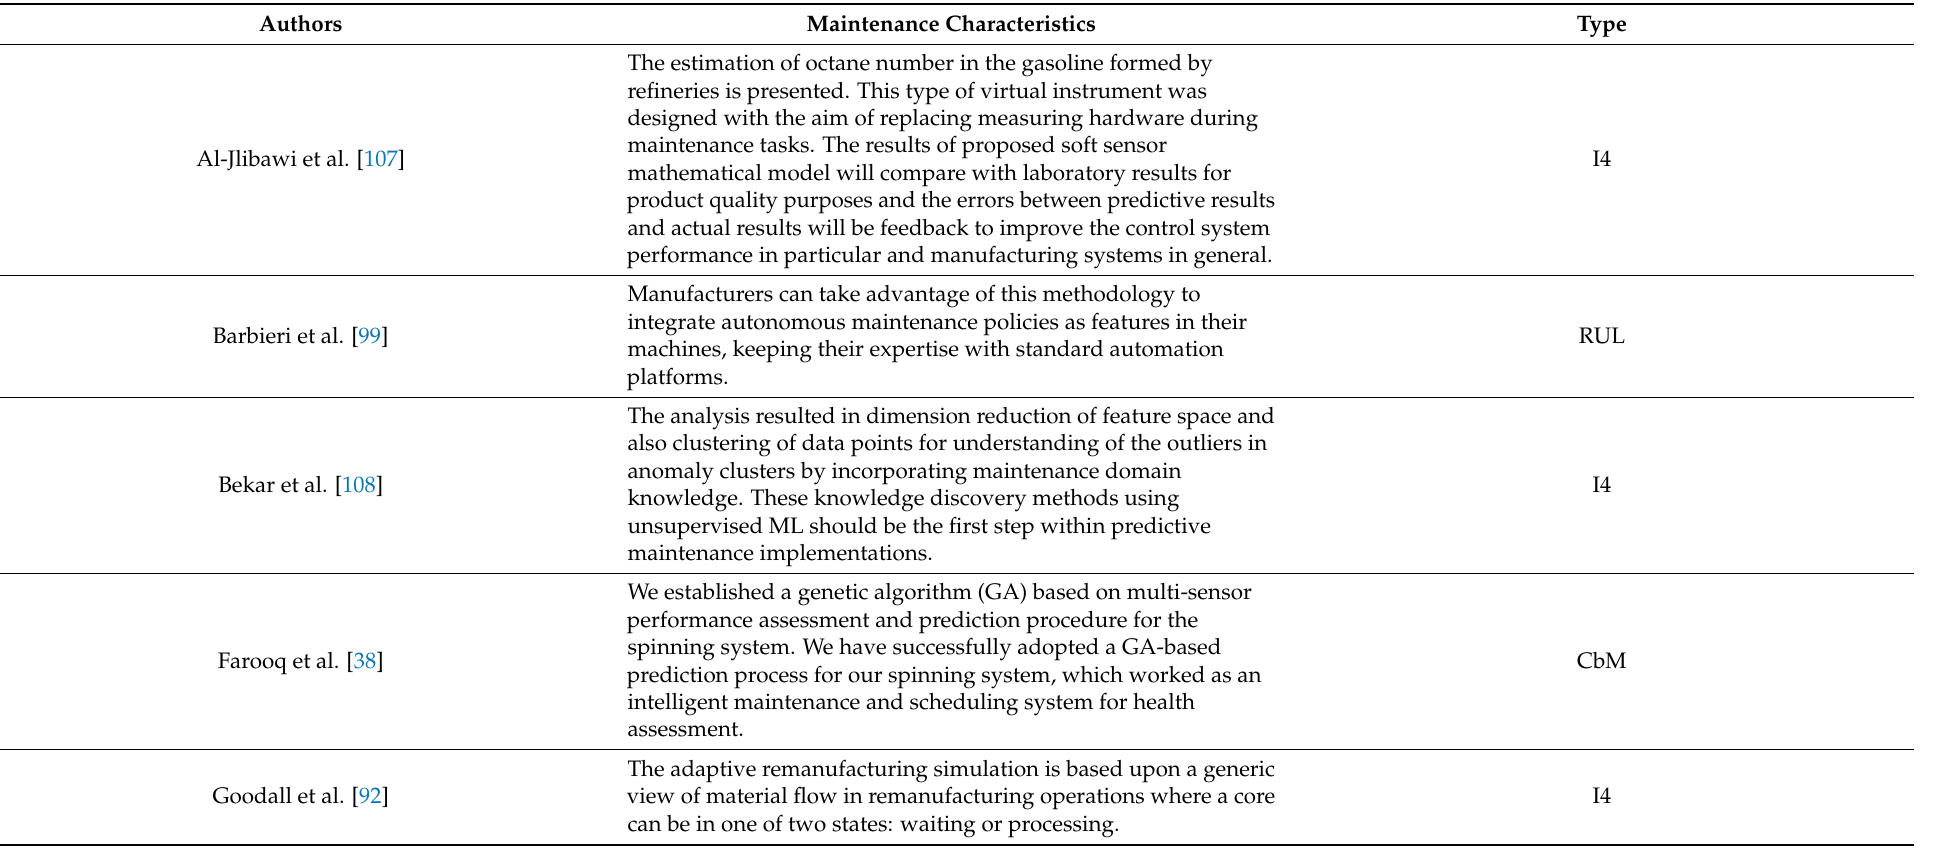
Table 6. Maintenance process characteristics